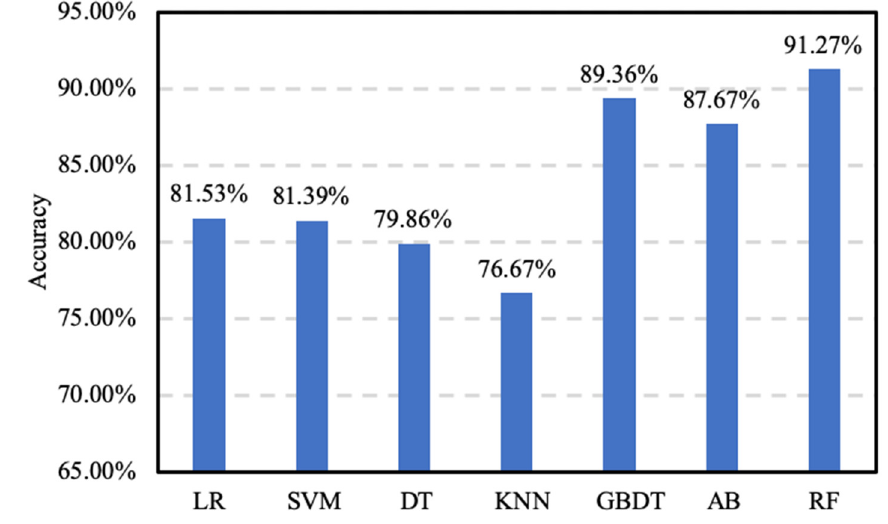
Figure 13. The accuracy of different classification algorithms on the test set.